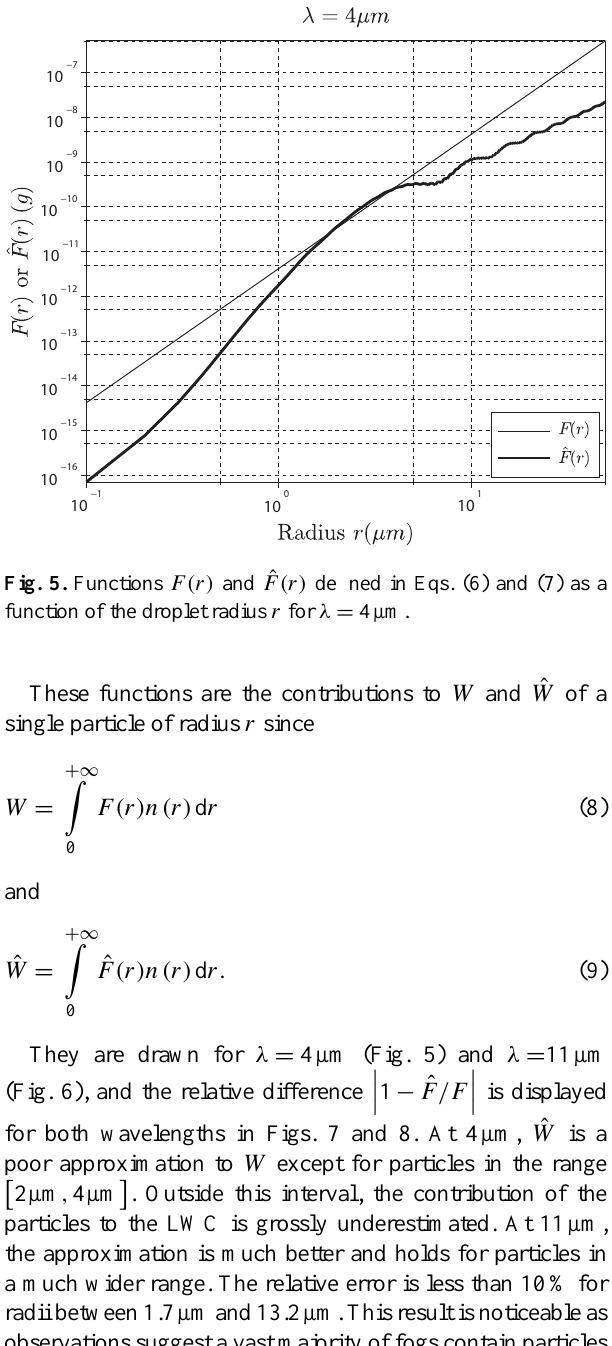
Fig. 4. As Fig. 3, for λ = 11µm.